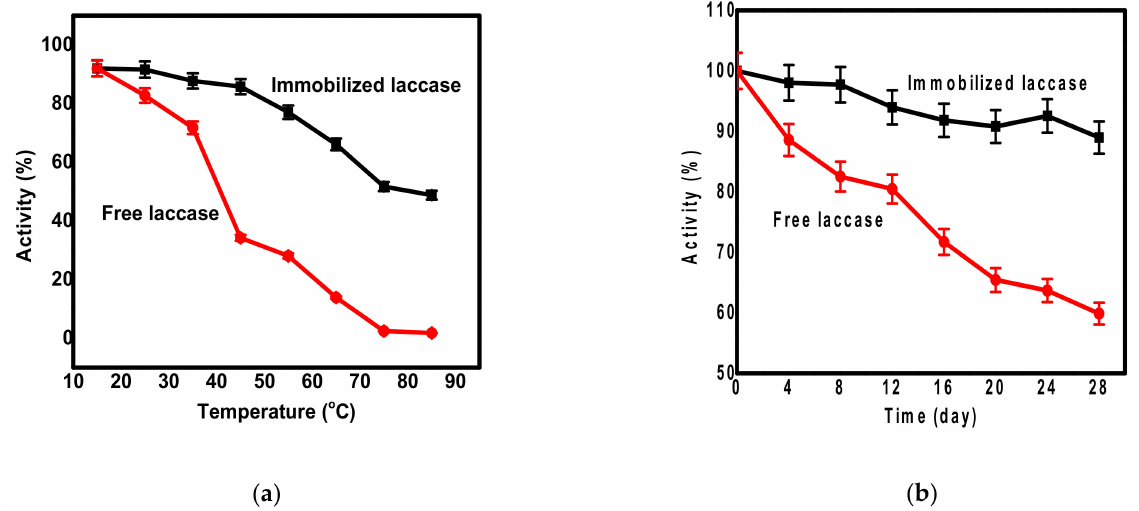
Figure 3. The effect of the ( a ) thermal stability and ( b ) storage time on the free and immobilized